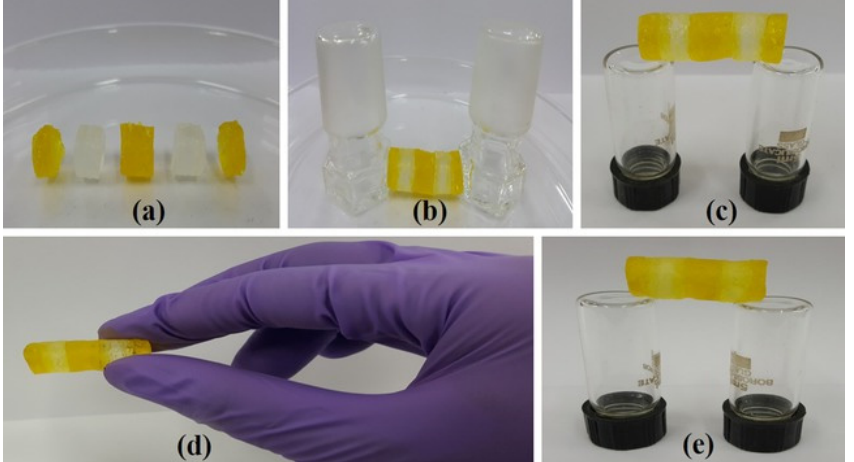
Figure 80. Mesitylene gels at 0.3% w / v . ( a ) Pieces of doped and undoped gel in alternating order; ( b ) Compressing the pieces to promote self-healing; ( c ) Rod of gel after self-healing; ( d ) Handheld gel rod; ( e ) Image showing the diffusion of the azo dye into the undoped segments of the gel rod. Reprinted with permission from [61]. Copyright 2017 John Wiley & Sons, Inc.